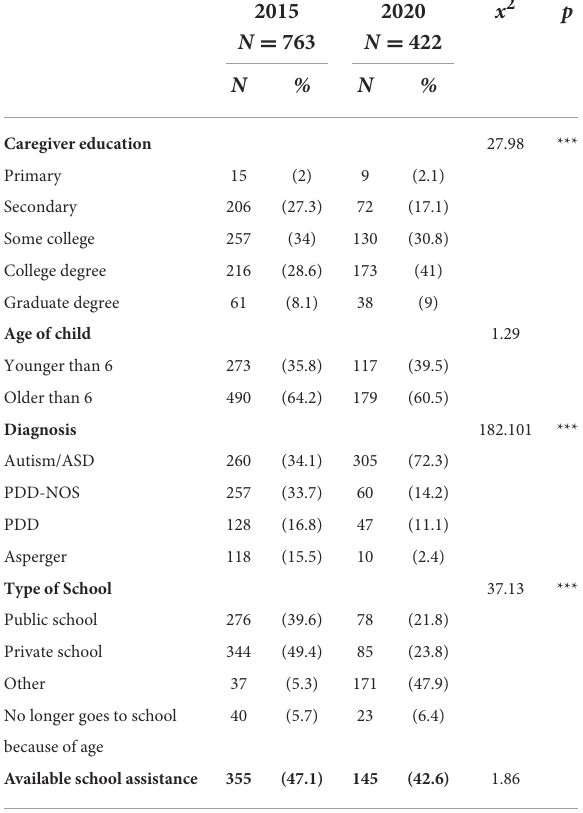
TABLE 1 Demographic characteristics of the